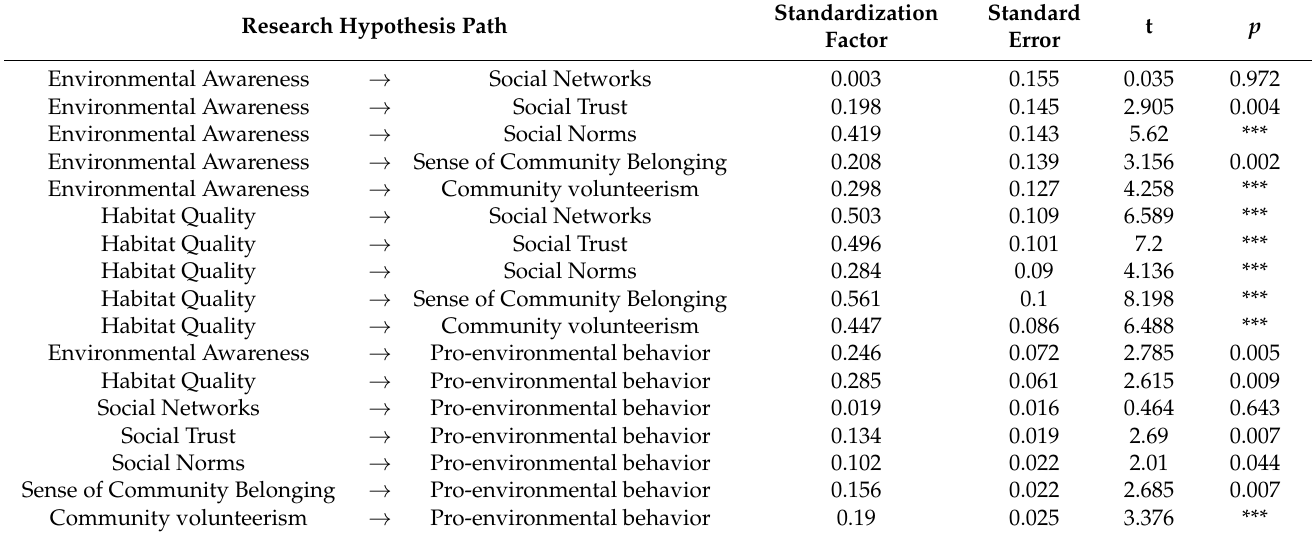
Table 6. Descriptive statistics of the